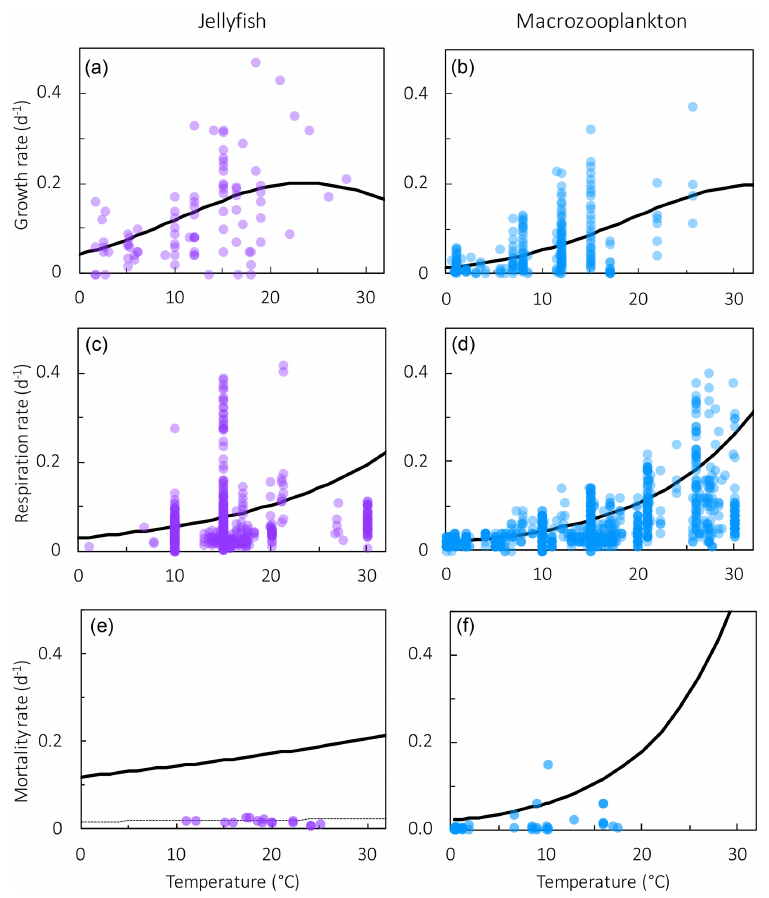
Figure 3. Maximum growth rates (a, b) , respiration rates (c, d) and mortality rates (e, f) for jellyfish (left; purple) and macrozooplankton (right; blue) PFTs as a function of temperature. The fit to data is shown in black, using the parameter values from Tables 2 and 4. Growth rates are the same as shown in Fig. 2 but on a different scale. For jellyfish mortality, the thin dashed line is the fit to data, and the solid line is the adjusted fit (Table